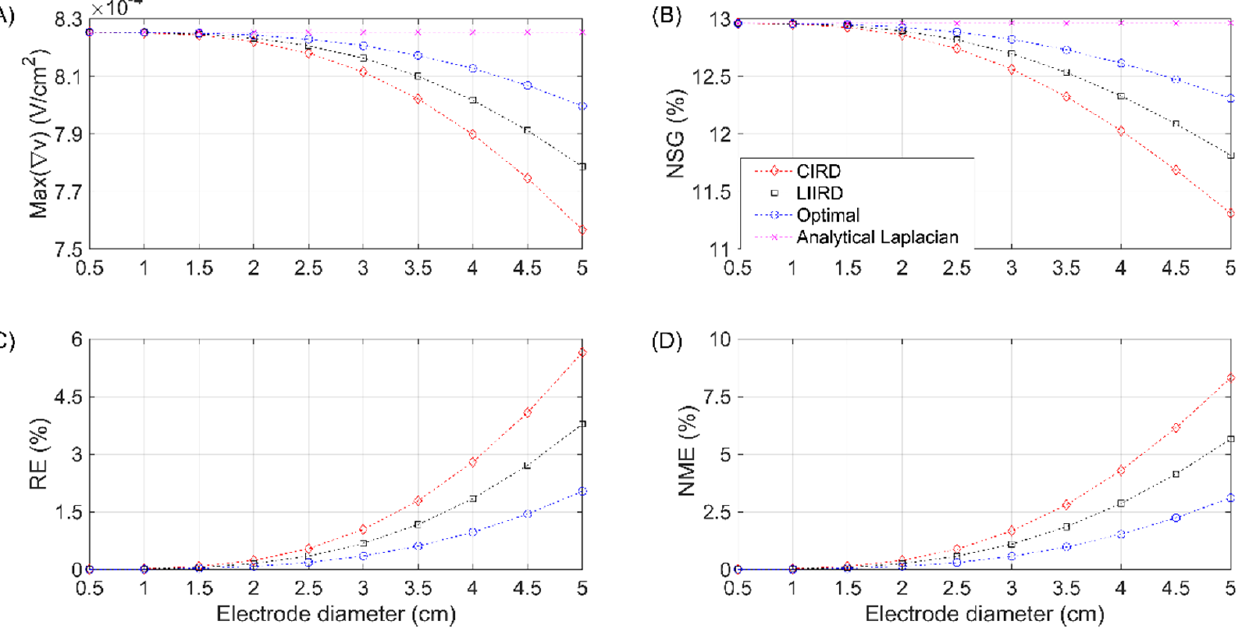
Figure 4. Maximum Laplacian amplitude (Max( ∇ v )), normalized spatial gradient (NSG), relative (RE), and normalized maximum errors (NME) computed via the finite element method modeling for tripolar concentric ring electrode diameters ranging from 0.5 cm to 5 cm and a dipole depth of 3 cm.